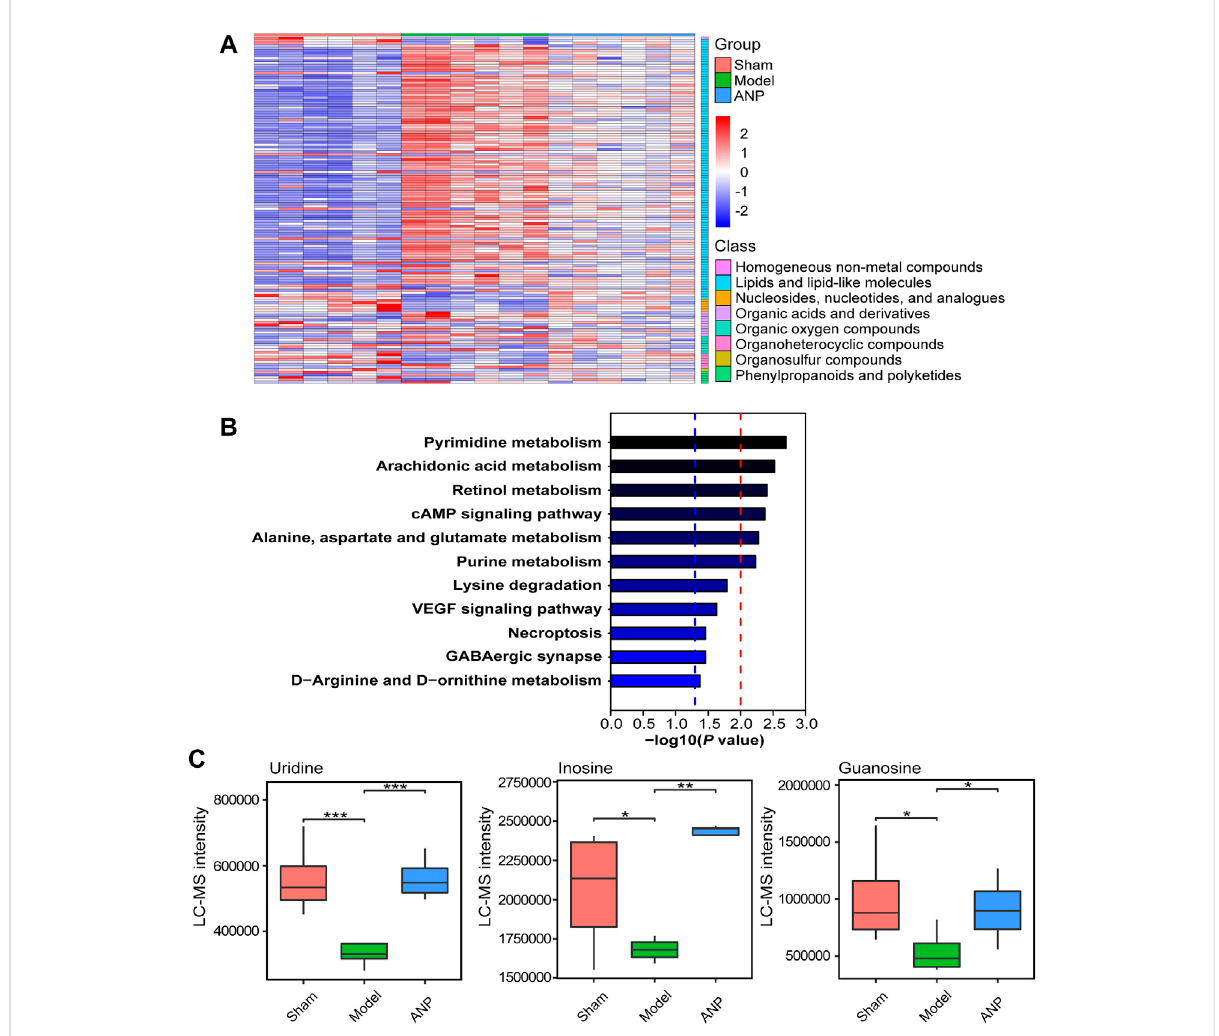
FIGURE 7 The KEGG metabolic pathway analysis of the metabolites reversed by ANP. (A) The heatmap of the metabolites reversed by ANP (values were log10-transformed). (B) The KEGG metabolic pathways. The blue dotted line represents -log10 ( p value) = 1.3; the red dotted line represents -log10 ( p value) = 2.0. (C) The statistical analysis of the key differentially expressed metabolites. Statistical differences were examined by t -test. * p < 0.05, ** p < 0.01, *** p <